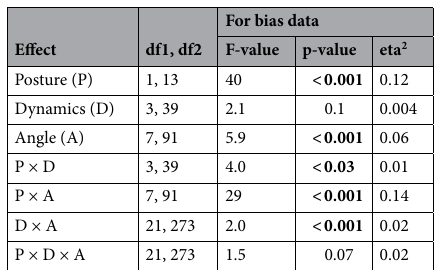
Table 4. Results from the ANOVAs for the difference data of Experiment 3.